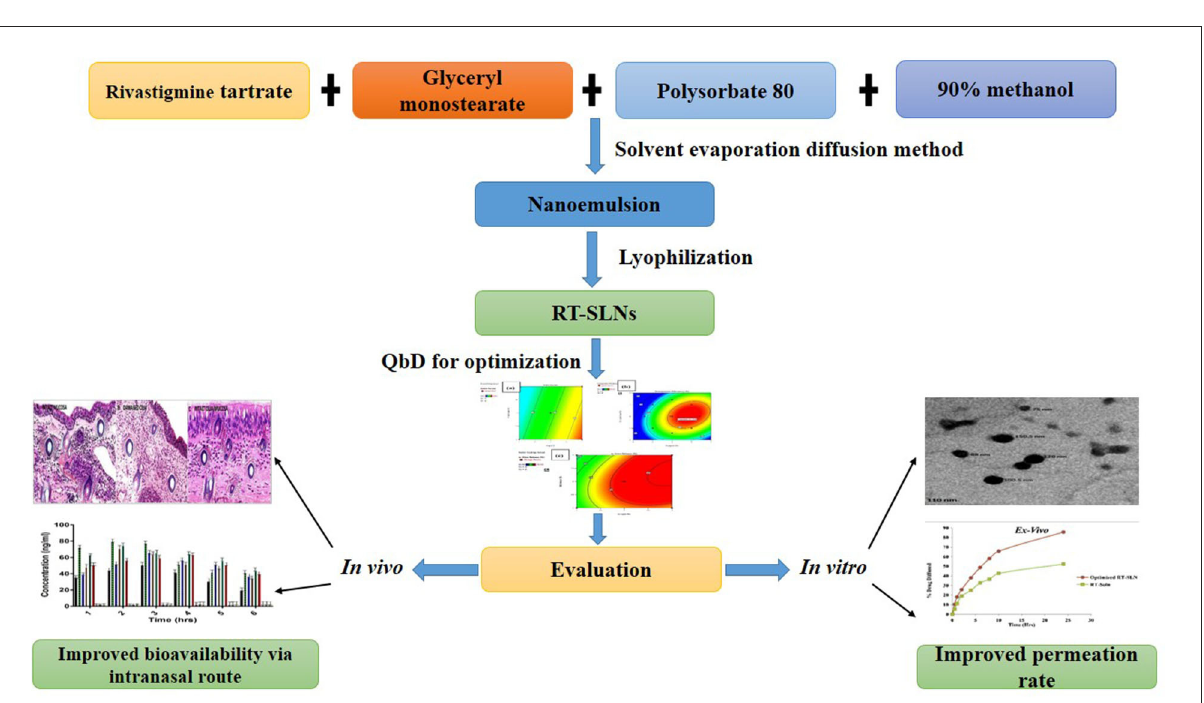
FIGURE12 Schematic representation of development and evaluation of SLNs for intranasal route.